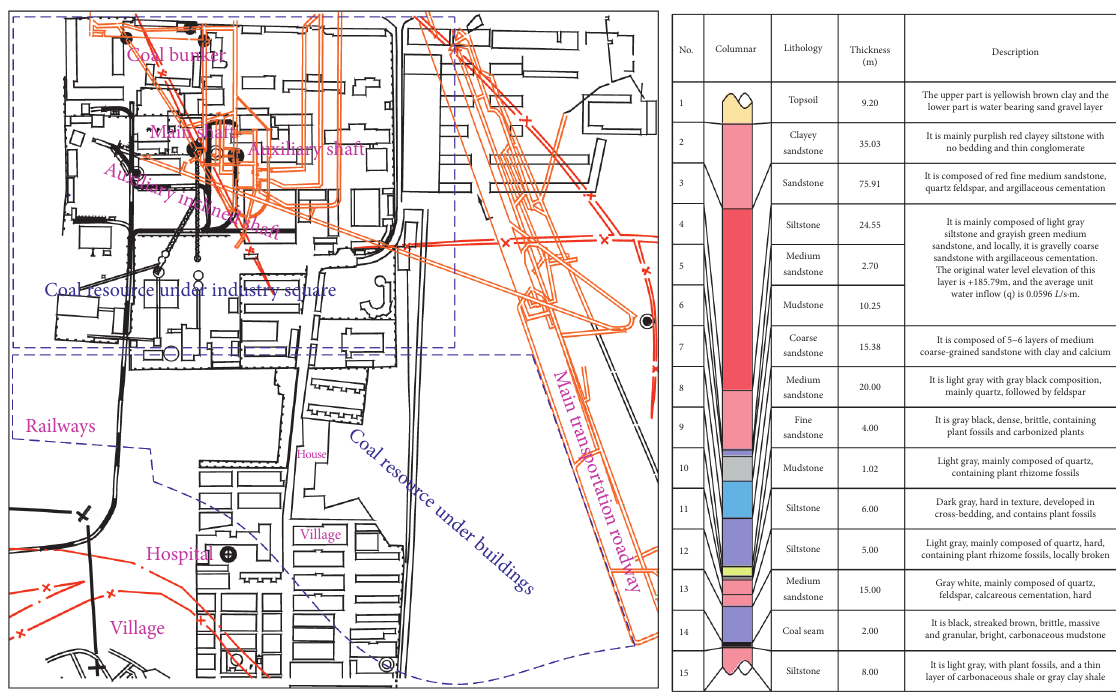
Figure 1: Distribution of surface buildings and generalized stratigraphic column in the study area.